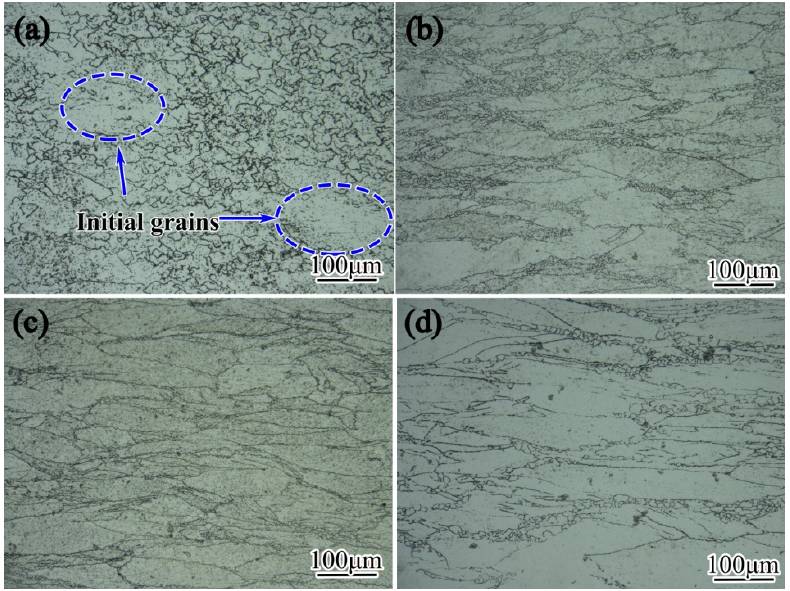
Figure 5. Microstructures of 300M steel compressed at 900 °C and at ( a ) 0.01 s − 1 , ( b ) 0.1 s − 1 , ( c ) 1 s − 1 , and ( d ) 10 s − 1 .